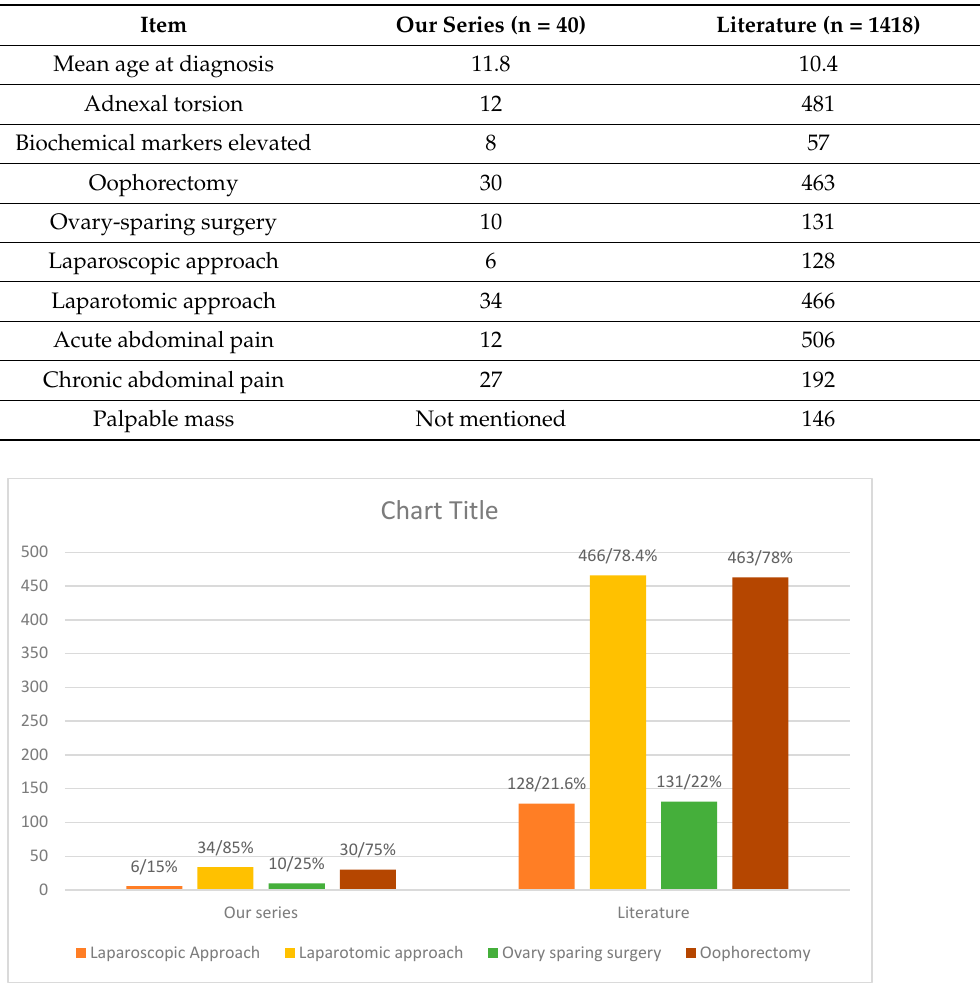
Figure 1. Surgical approach in ovarian teratomas over the years.